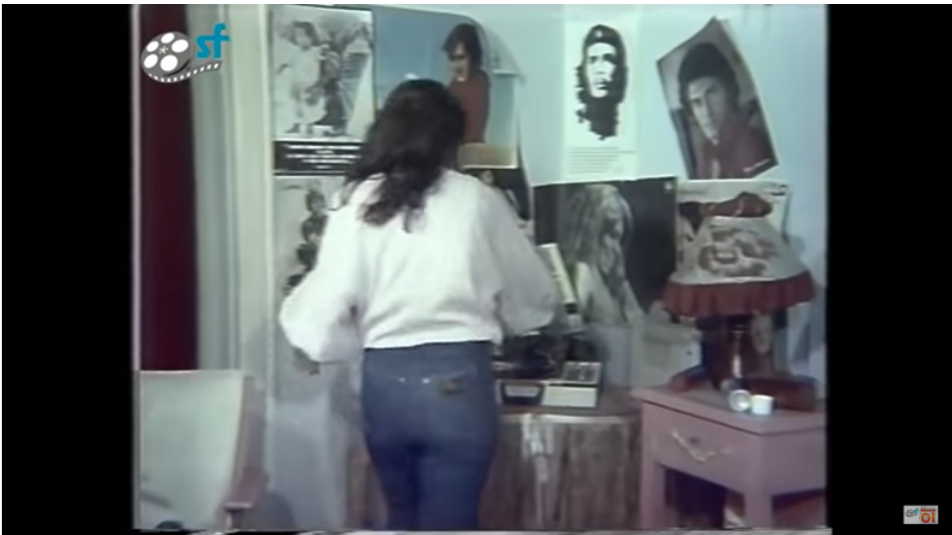
Figure 3- Cemile in her Communist